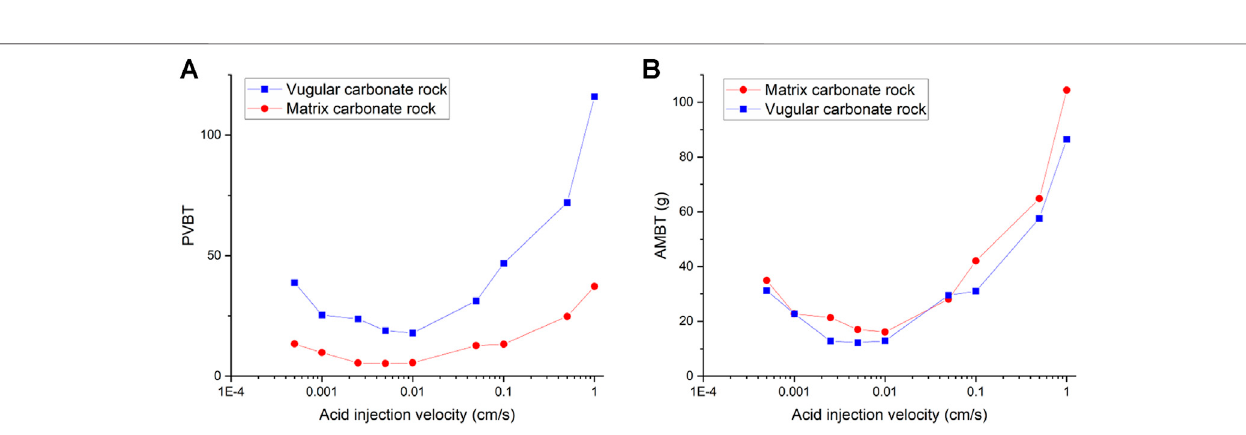
Frontiers in Earth Science |